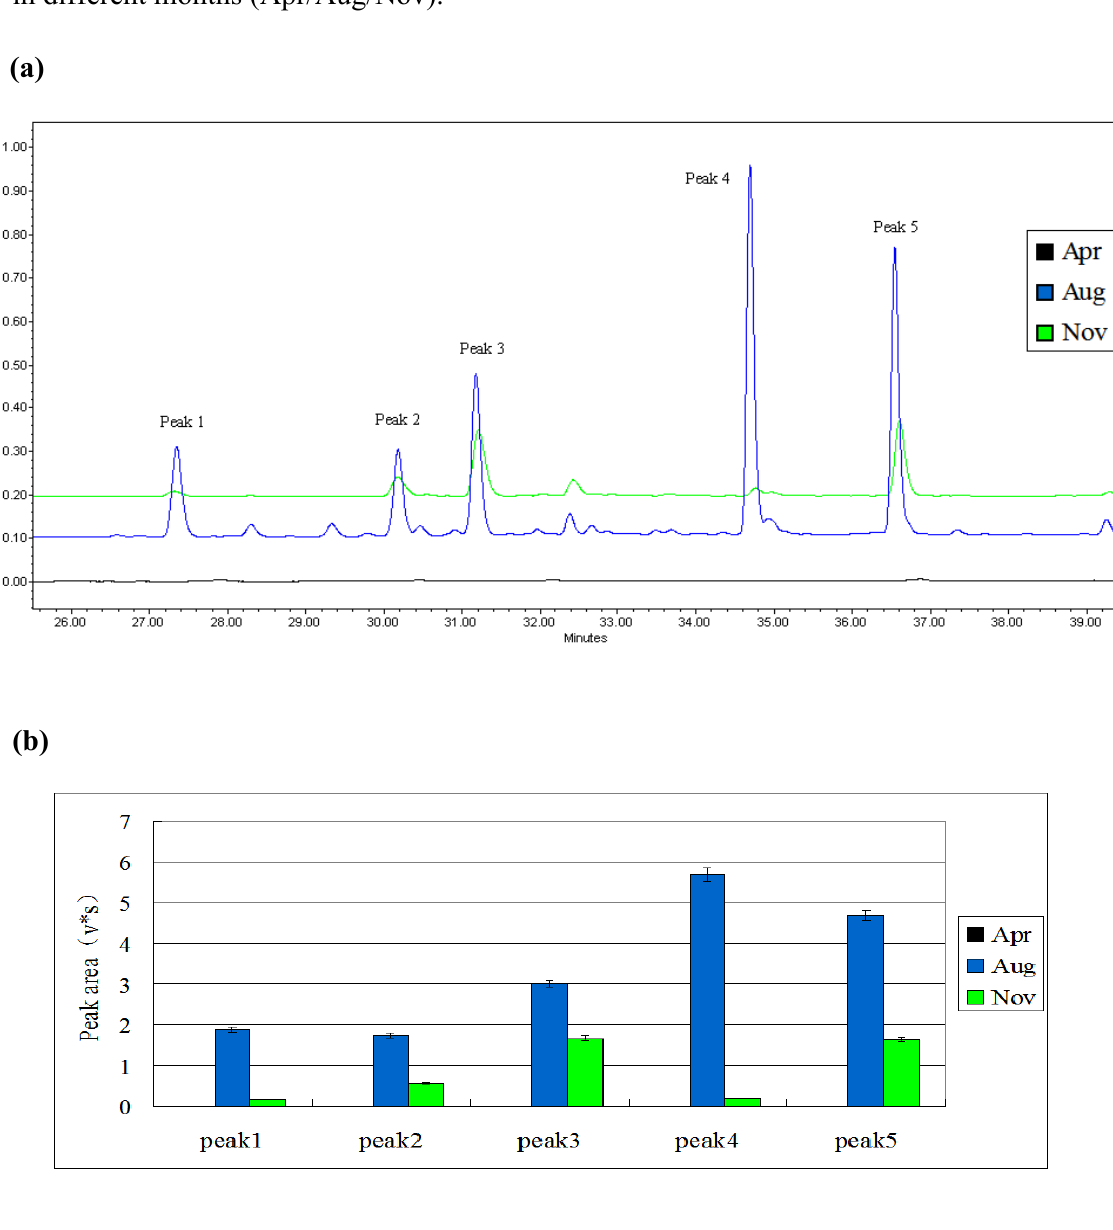
Figure 2. (a) Induced result of different months detected by HPLC fingerprint.HPLC chromatograms of the induced mulberry leaves’ extract obtained in different months. The black curve represents the sample of Apr, the blue curve represents the sample of Aug, and the green curve represents the sample of Nov. A 250 mm Waters Symmetry C18 column was utilized for this experiment. (b) Comparison of peak areas of five induced compounds in different months